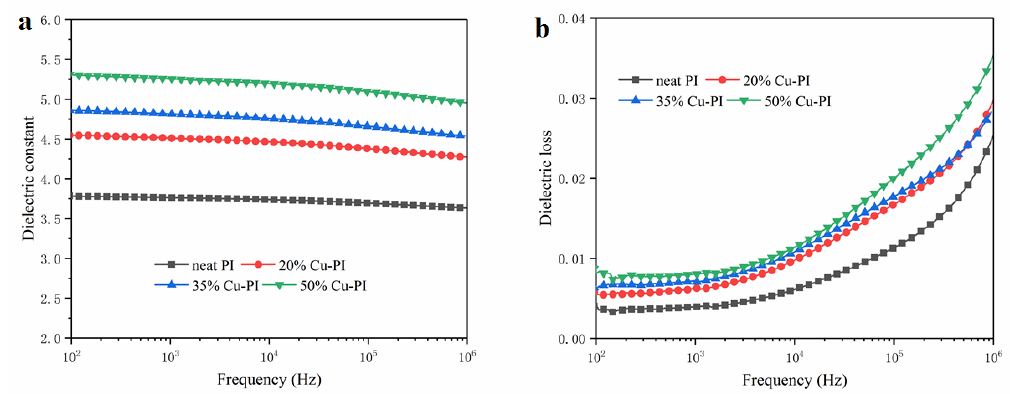
Figure 3. Dielectric properties of neat PI and Cu-PI films. ( a ) Dielectric constant; ( b ) dielectric loss.